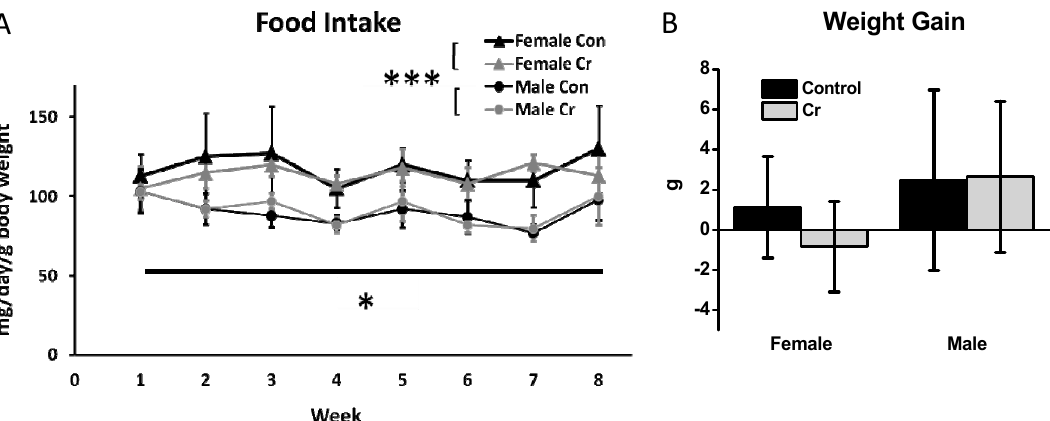
Figure 3. Food intake and weight gain as a function of diet in 3xTg mice. ( A ) Plot depicting food intake in adult (7-month-old) 3xTg control mice and 3xTg mice supplemented with Cr. Food intake (mg) was measured twice / week over the 8-week dietary intervention, averaged across the week, and expressed as mg / day. The mg / day value was divided by the animal’s body weight (g) to account for variations in food intake based on body weight. ( B ) Weight gain (ratio of g gained relative to initial body weight) over the 8-week study. Data were analyzed by two-way ANOVA. Mean ± SD depicted. Female control: n = 6; female Cr: n = 8; male control: n = 6; male Cr: n = 4; * p < 0.05; *** p < 0.001.